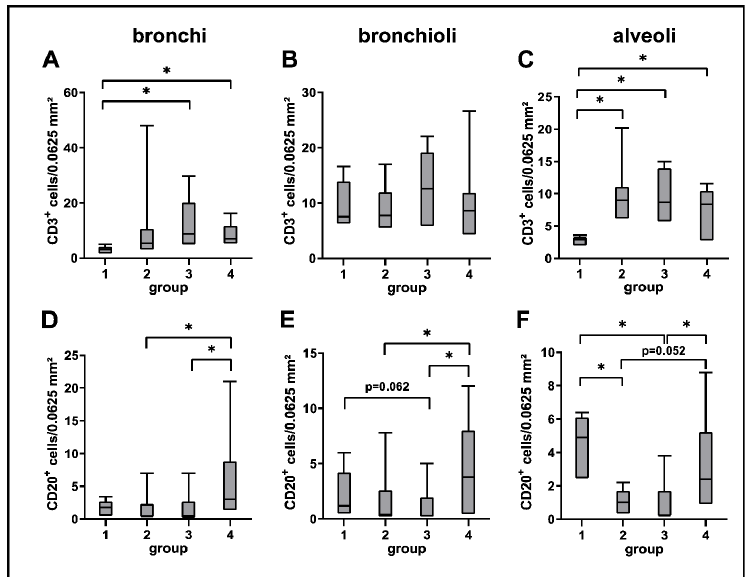
Figure 6. Quantification of adaptive cellular immune responses in canine distemper virus (CDV)- infected lungs. CD3 ( A – C ) and CD20 ( D – F ) antigen detection. Groups: 1 = non-infected control lungs; 2 = acute CDV infection; 3 = subacute CDV infection; 4 = subacute-chronic CDV infection; box and whisker plots display median and quartiles with maximum and minimum values. Significant differences ( p ≤ 0.05, Kruskal–Wallis H test) are labelled by asterisks.